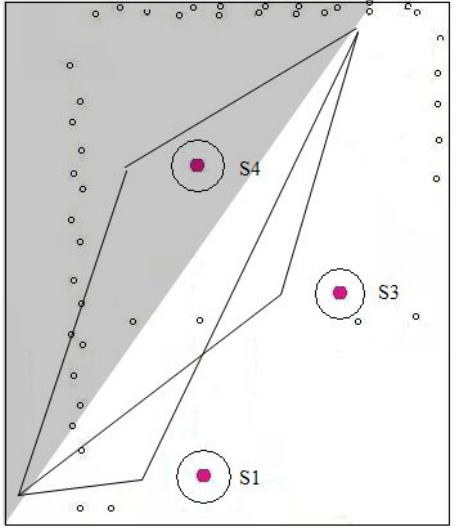
Figure 3: Scanner locations and the planimetric location of the targets